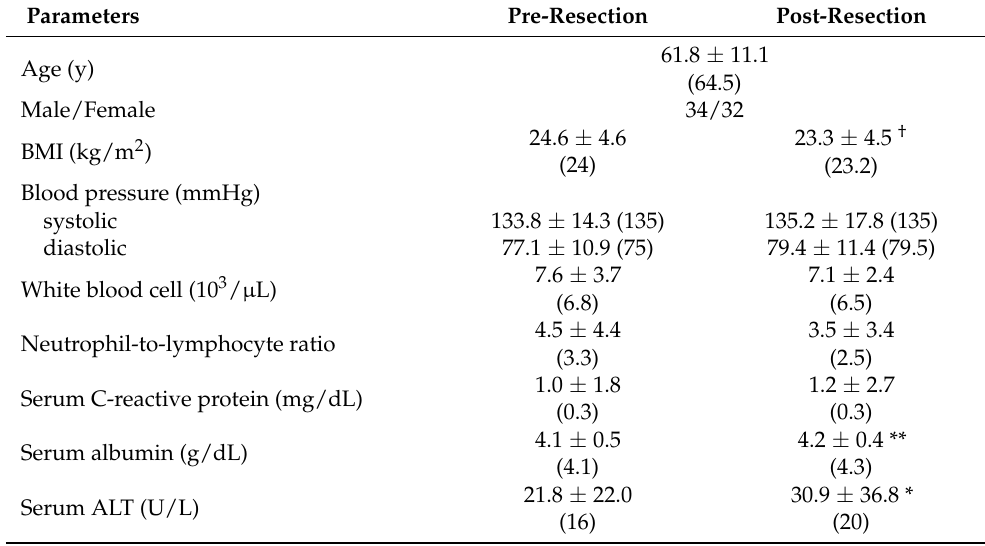
Table 1. Demographic and clinical characteristics of patients with colorectal cancer pre- and post-